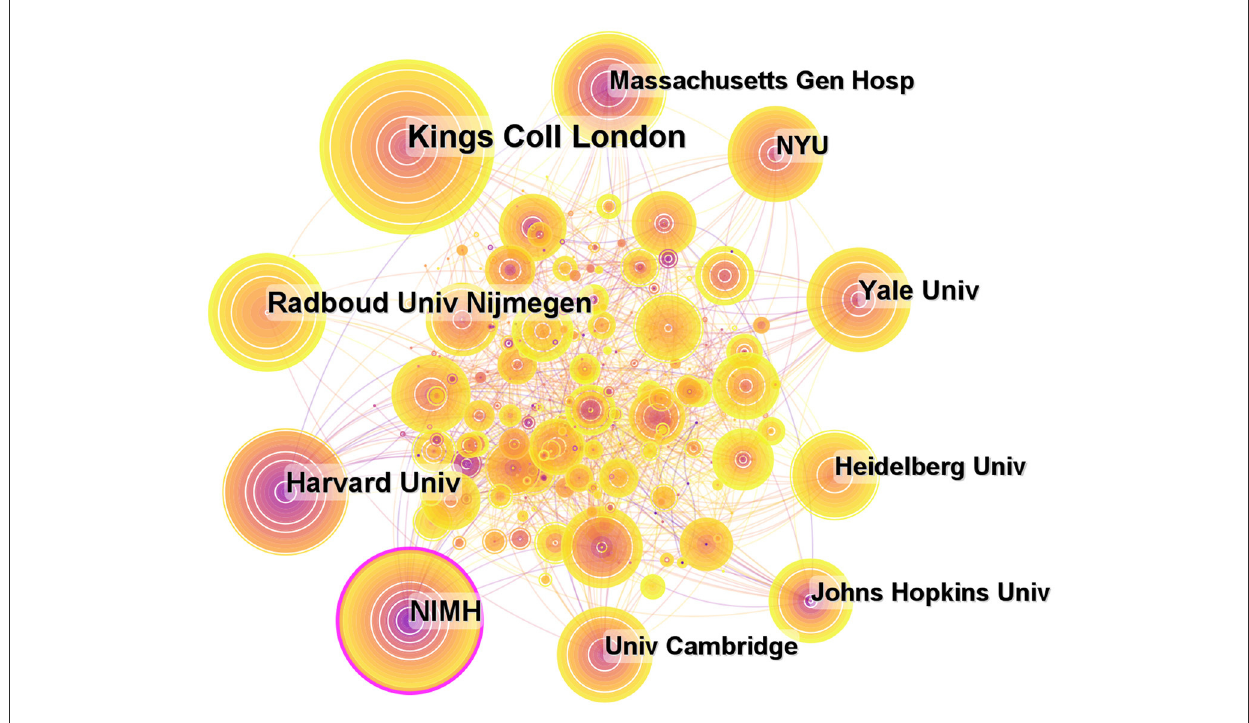
FIGURE5 Map of institutions researching ADHD neuroimaging from 1992 to 2022.